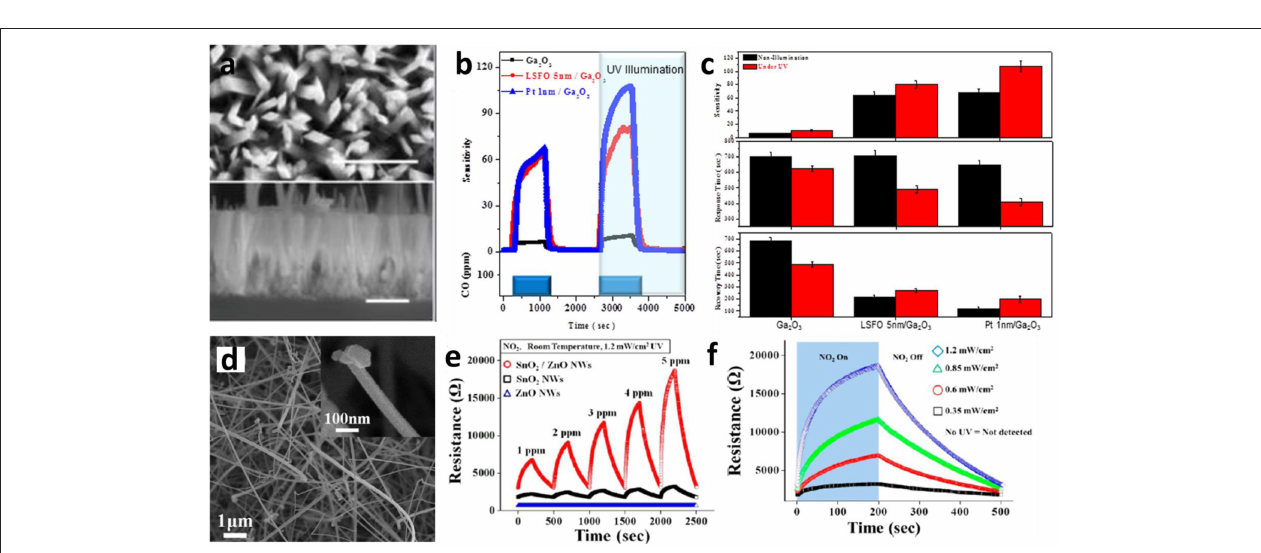
FIGURE 10 | (a) Top view and lateral view SEM images of as-prepared Ga 2 O 3 nanorod arrays. (b) The comparison of real-time CO gas sensing performance of pristine, LSFO decorated, and Pt-decorated b-Ga 2 O 3 nanorod arrays. (c) Histogram of normalized sensitivity, recovery time, and recovery time with or without UV illumination tested at 500 ◦ C. Reprinted with permission from Lin et al. (2017), copyright 2017 AIP Publishing. (d) SEM images of SnO 2 -ZnO core-shell nanowires. (e) The comparison of dynamic response of SnO 2 -ZnO hybrid nanowires, pristine SnO 2 nanowires, and ZnO nanowires under UV illumination at room temperature. (f) The dynamic response of SnO 2 -ZnO hybrid nanowires toward 5 ppm NO 2 under UV irradiation with different intensities. Reprinted with permission from Park et al. (2013), copyright 2013 American Chemical